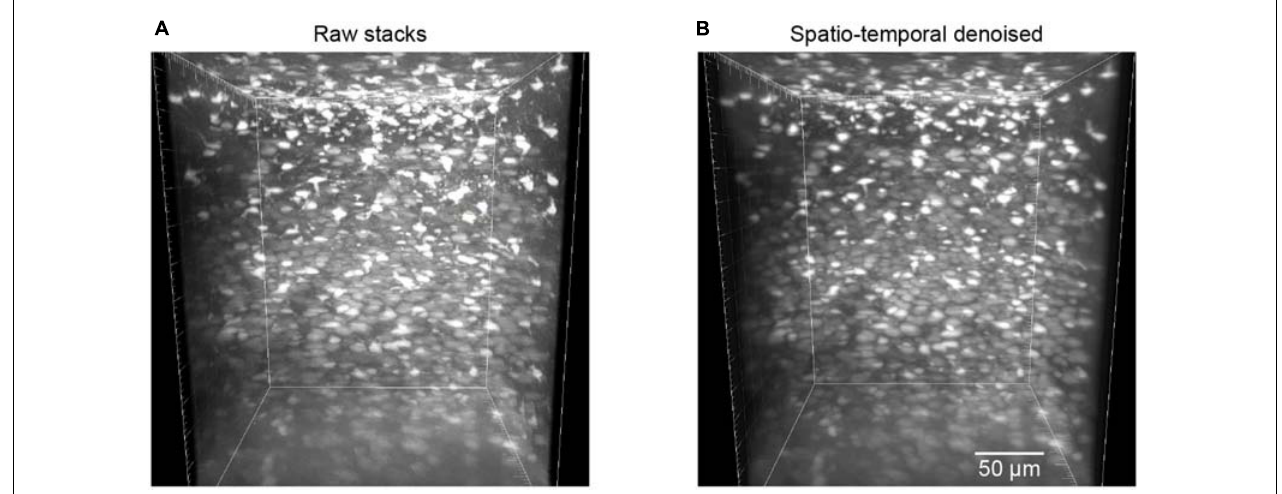
FIGURE 6 | Reconstruction of volumetric imaging data (z-stacks). (A) The raw image stacks (BIQI score of 70.67 ± 6.64). (B) The model blind spatiotemporal filtered image stacks (BIQI score of 41.28 ± 8.97). Data are presented as mean ±